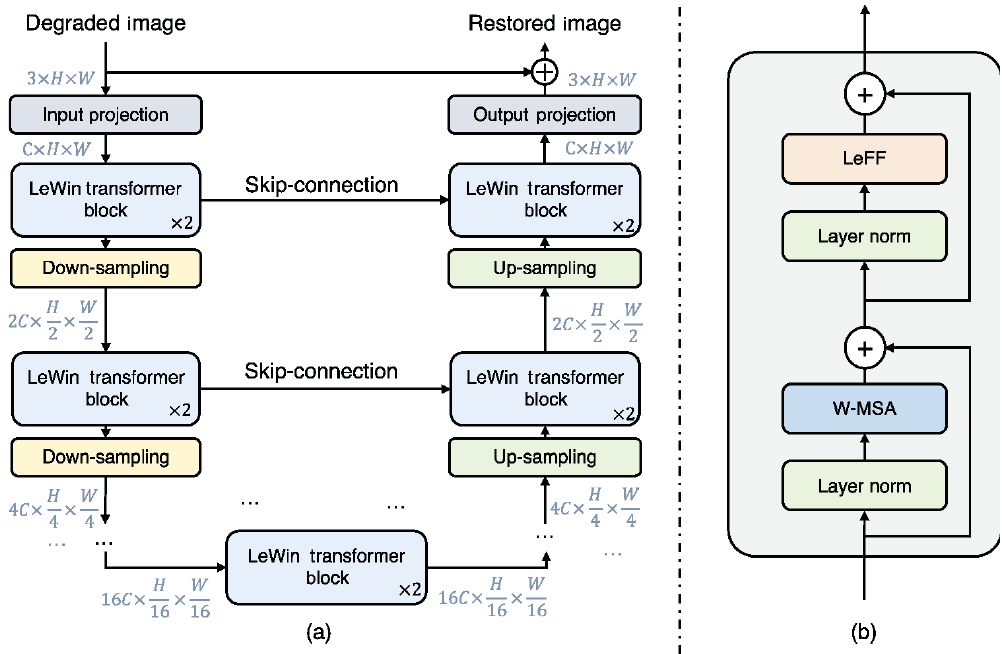
Fig. 16 (a) Overview of Uformer. (b) Structure of the LeWin transformer block. Reproduced with permission from Ref. [37], c (cid:2) The Author(s)